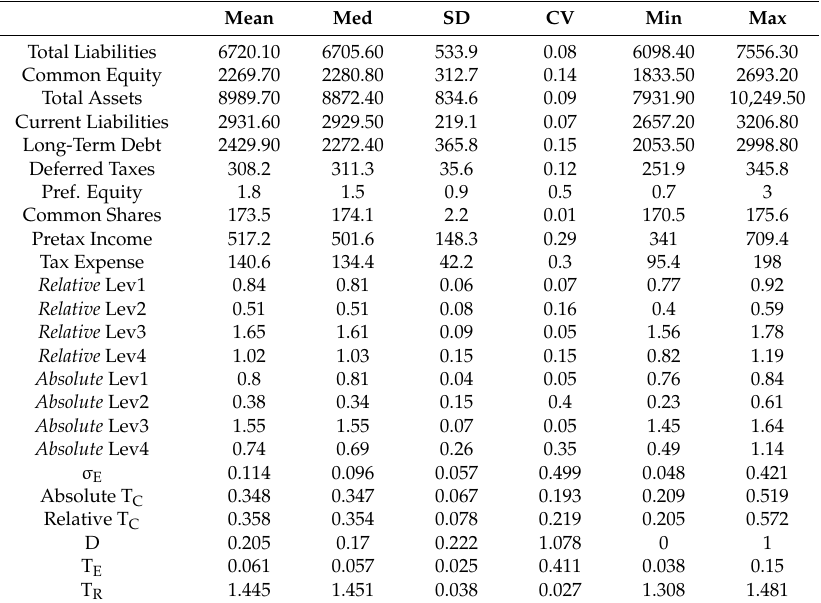
Table 1. Descriptive statistics of the corporate variables